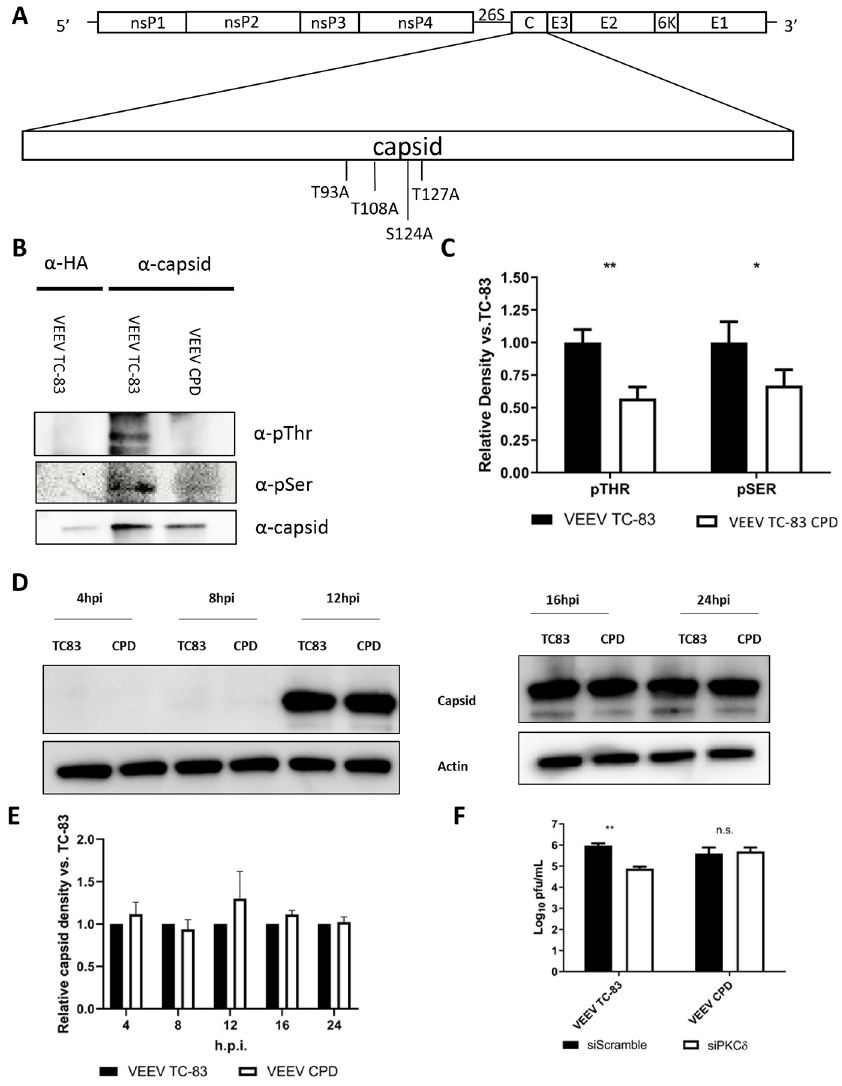
Fig 5. VEEV CPD shows decreased phosphorylation of capsid and replication is not sensitive to loss of PKC δ . A) Schematic of the VEEV genome indicating the alanine substitutions made at T93, T108, S124, and T127. B) Vero cells were infected with either VEEV TC-83 or VEEV CPD (MOI 1.0). Cells were collected at 16 hpi, lysed, and immunoprecipitated with α -HA or α -VEEV capsid antibodies. Protein complexes were bound to Protein G Dynabeads, samples were run on SDS-PAGE, and western blot analysis was performed for phospho-Ser or phospho- Thr residues. Images are representative of 3 biological replicates. C) Western blot band density was analyzed on BioRad Quantity One software and normalized to capsid. Normalized values were calculated relative to TC-83 infected cells. Quantitation was performed for 3 biological replicates. � = p < 0.05 D) Vero cells were infected with either VEEV TC-83 or VEEV CPD (MOI 1.0). Cells were collected at the indicated time points, lysed, samples were run on SDS-PAGE, and western blot analysis was performed for capsid and actin. E) Band density from panel D was analyzed on BioRad Quantity One software and normalized to actin. Normalized values were calculated relative to TC-83 infected cells respective to each time point (for example, 16hpi CPD is relative to 16hpi TC-83 and 24hpi CPD is relative to 24hpi TC-83). Images were split into early and late time points to allow for longer exposure on 4 and 8 hpi without over exposing the later time points. F) U87MG cells were transfected with 50 nM scramble control or PKC δ siRNAs. Seventy-two hours post-transfection, cells were infected with either VEEV TC-83 or VEEV CPD (MOI 0.1) and viral supernatants collected at 16 hpi for viral titer determination via plaque assay. Values are an average of 3 biological replicates ± standard deviation � = p < 0.05, �� = p <